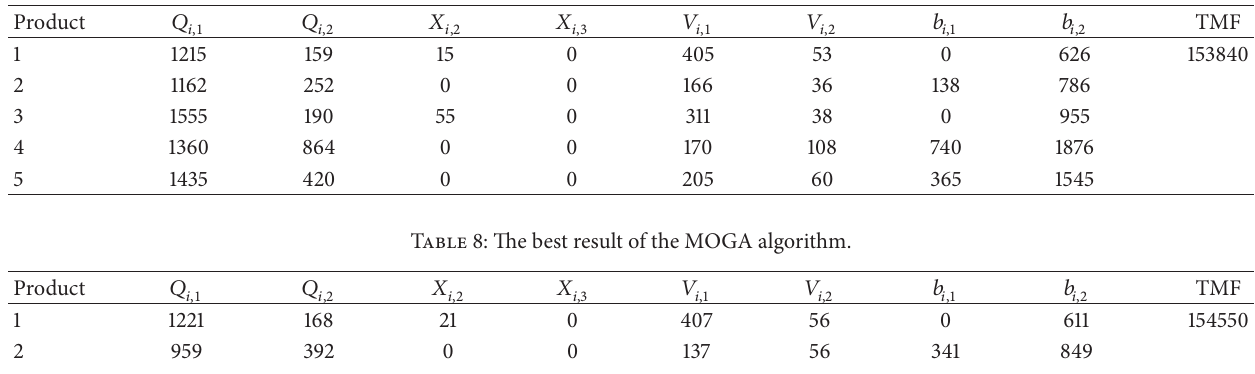
Table 7: The best result of the MOPSO algorithm.